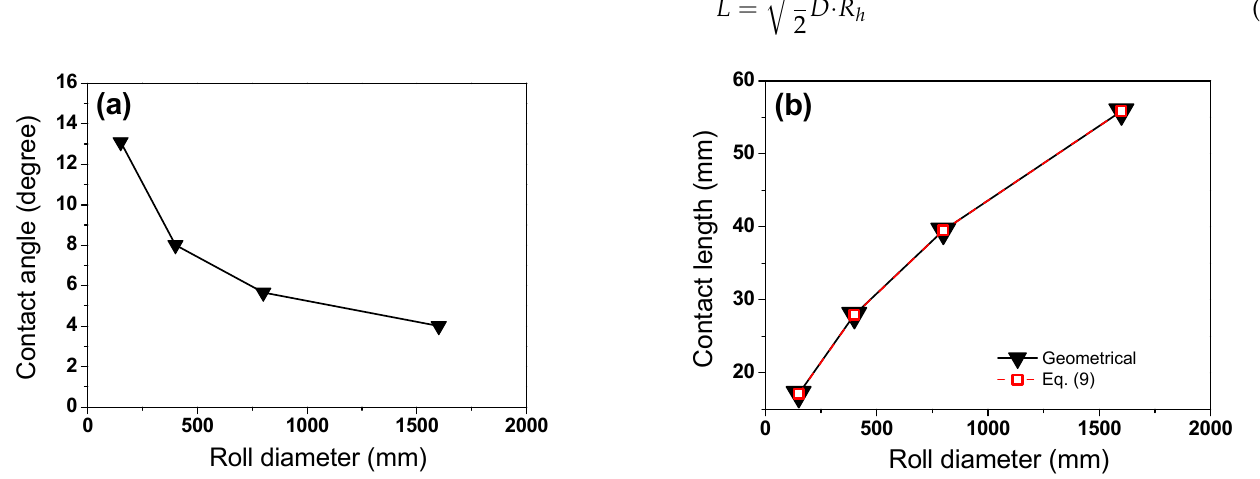
Figure 10. Variations in ( a ) α and ( b ) L with the roll diameter during wire flat rolling.